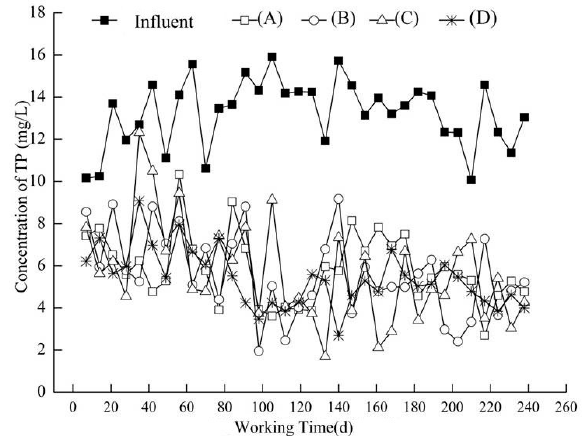
Figure 5. Total phosphorus (TP) removal rates in the four different devices (A–D).